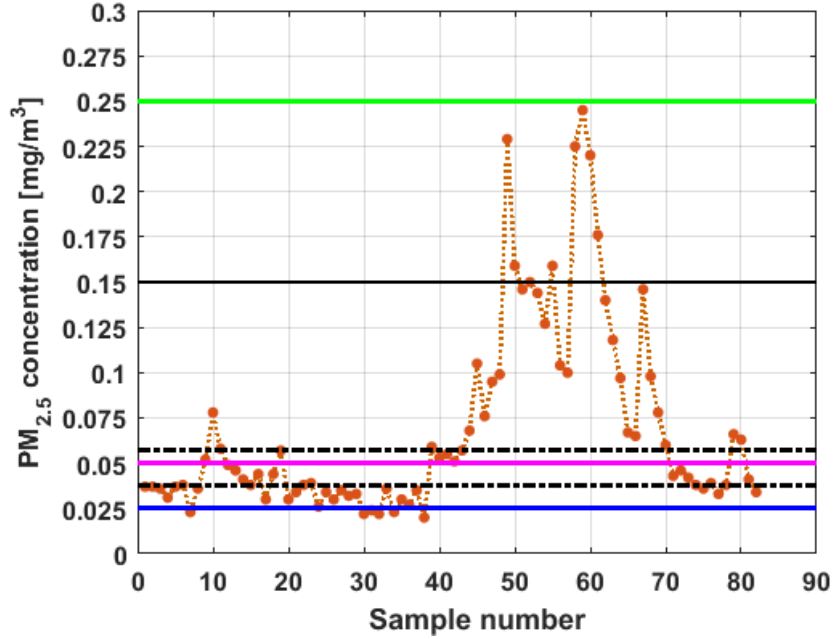
Figure 16. Observations of variable Y 3 , together with the 95% nonparametric confidence interval for the median (shown with dashed black lines) and the limits that define the categories of the level of air pollution by PM 2.5 (Desirable level: Blue line; Acceptable level: Magenta line; Caution level: Black line; Alarm level: Green line).